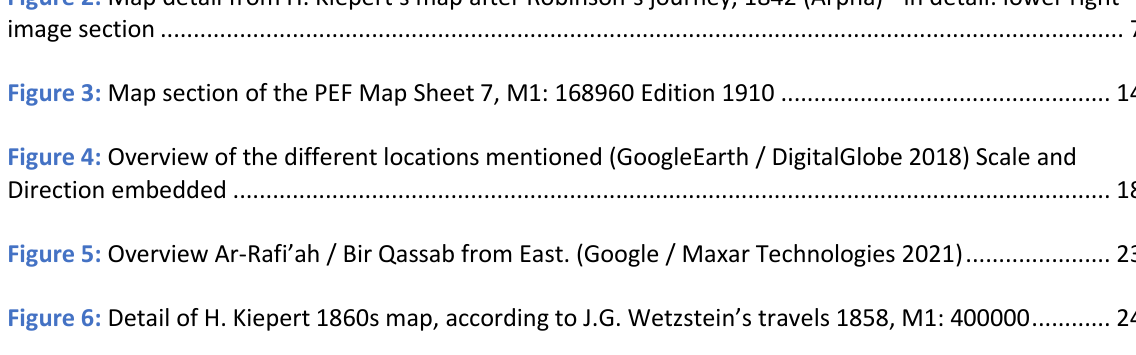
Figure 2: Map detail from H. Kiepert’s map after Robinson´s journey, 1842 (Arpha) - in detail: lower right